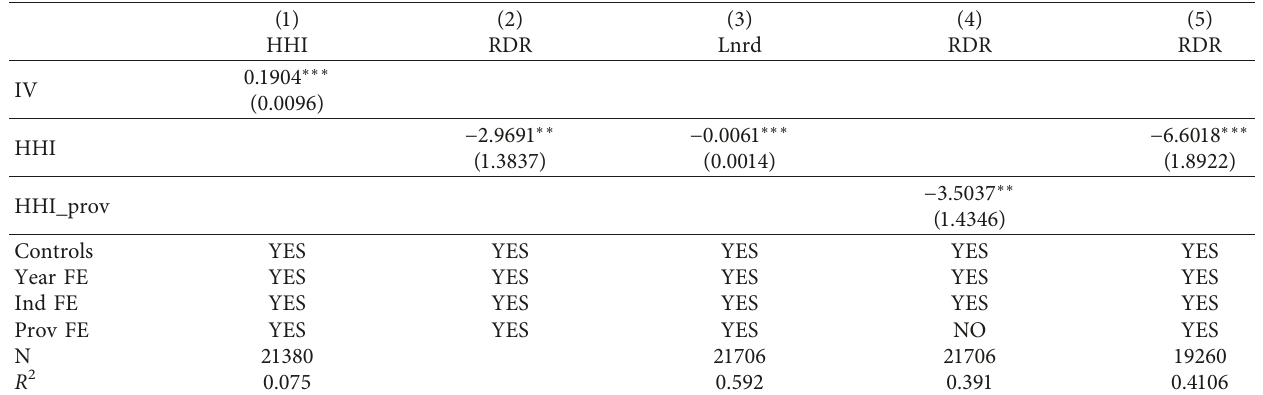
Table 4: Robustness test